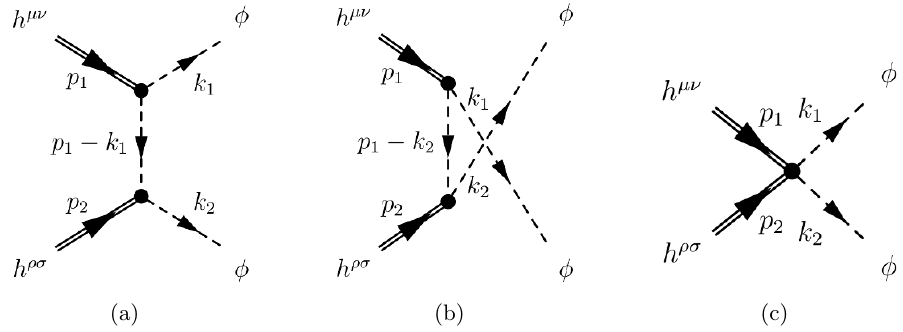
Figure 8 . Tree-level diagrams relevant to the hh ! (cid:30)(cid:30) scattering process in the free scalar theory.